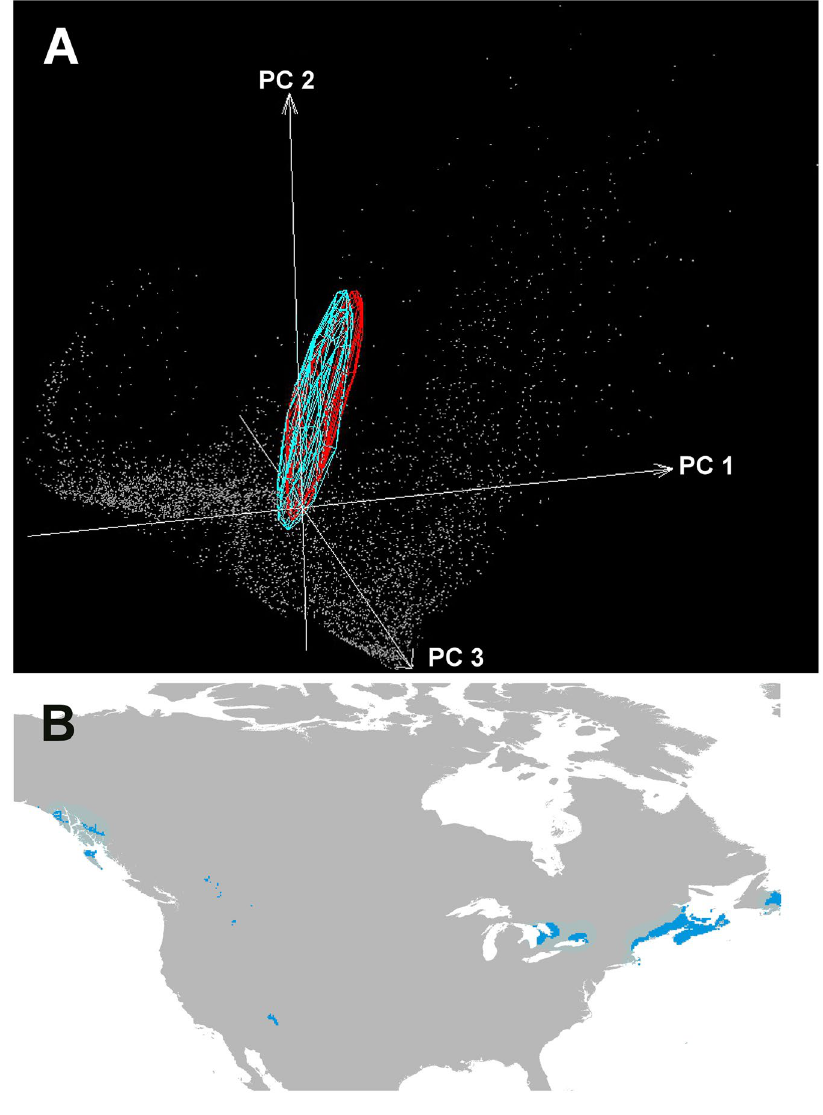
Figure 2. Analogous environments in native and invaded areas. Top: visualization of similar overlapping environments in native (blue convex polyhedron) and invaded (red convex-polyhedron) areas for Gray Squirrels. Note the many unshared environments across the native range (gray points). Axes are the first three principal components derived from the original climate layers. Bottom: geographic areas with analogous environments in the native range of North America (blue). Note the many unshared environments across the native range (gray areas). Top figure done using NicheA 3.0 [ref. 48]. Bottom figure done using ArcGIS 10.2 (ESRI, Redlands, CA, http://www.esri.com/).